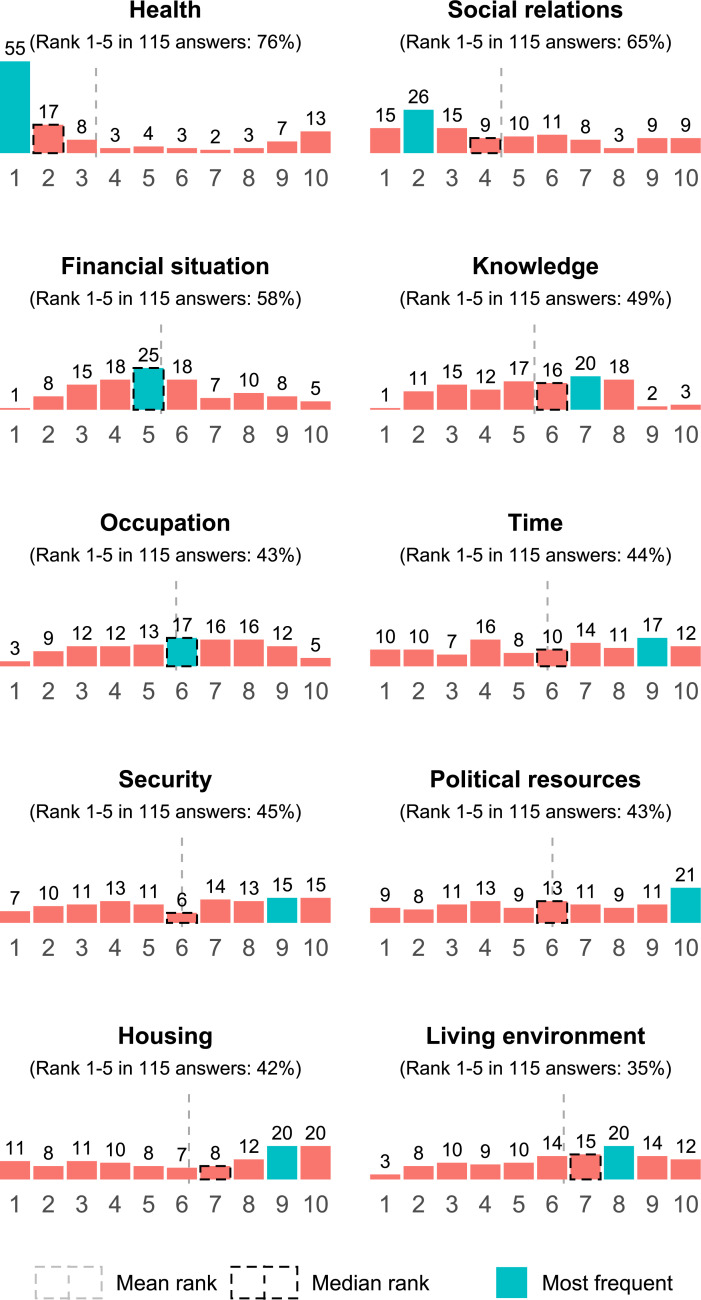
Distribution of ranks per dimension.Distribution of ranks for all capability dimensions, with the number of rankings above the bars. Teal indicates the most frequently chosen rank, the dashed grey line is the mean rank, and the dashed black rectangle is the median rank. Subheadings denote the proportion of times a dimension was ranked 1–5 out of the 115 answers.